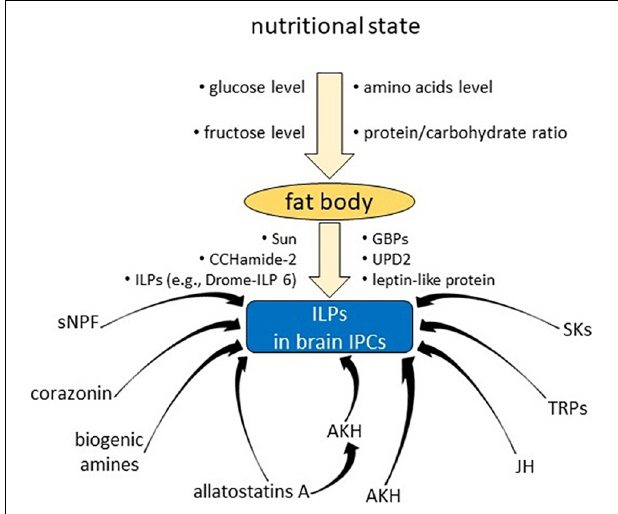
FIGURE 1 | Examples of various factors affecting synthesis/secretion of insulin-like peptides in insulin producing cells in the brain.